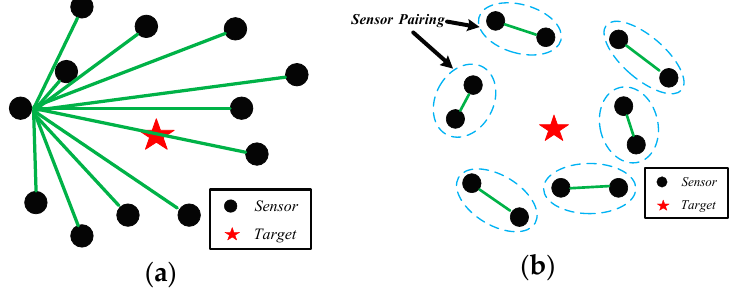
Figure 1. Sensor pairing. ( a ) Centralized Localization; ( b ) Distributed localization.